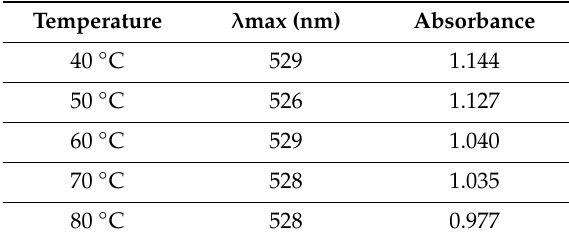
Figure 3. UV-Vis adsorption spectra of AuNPs synthesized by gelatin at different temperature of ( a ) 40, ( b ) 50, ( c ) 60, ( d ) 70 and ( e ) 80 °C. Table 2. UV-Vis results of branched AuNPs synthesized by gelatin at different temperatures .